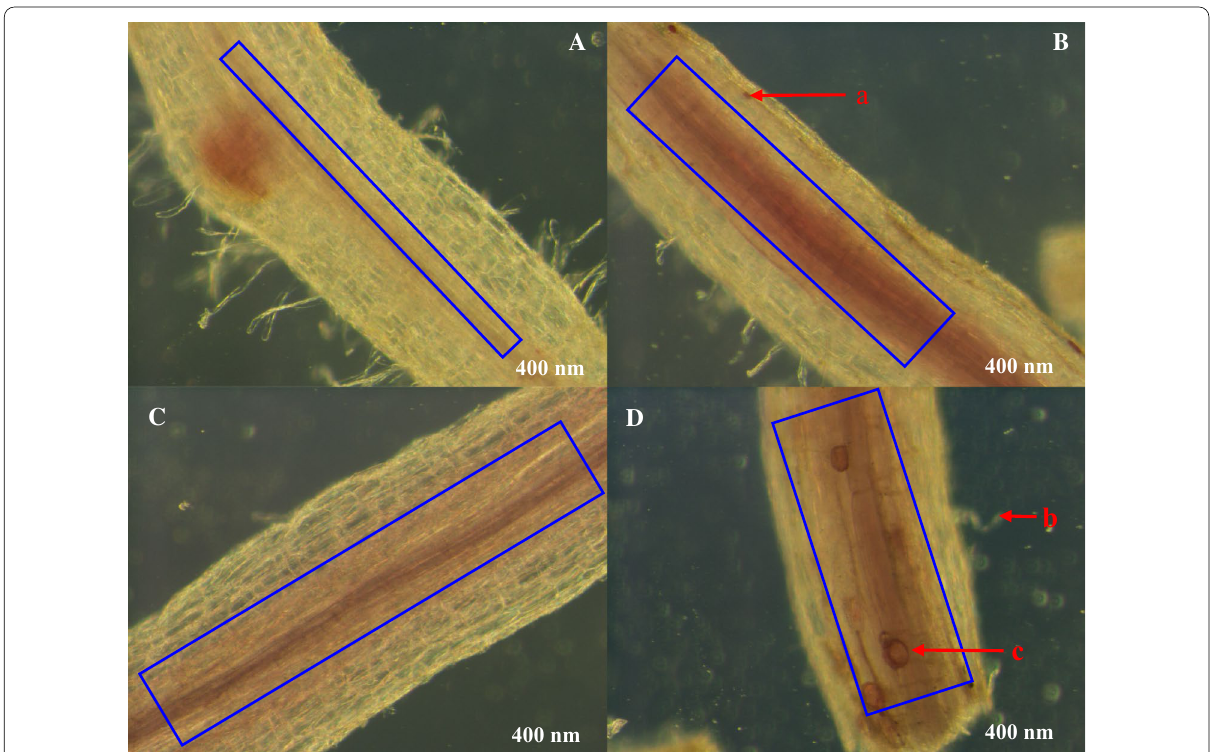
Fig. 2 The degree of mycorrhizal infection under different treatments under stereomicroscope. A , B : Single inoculation of Funneliformis mosseae (Fm), C Single inoculation of Bacillus megaterium (Bm), D Mixed Inoculation Fm the degree of mycorrhizal